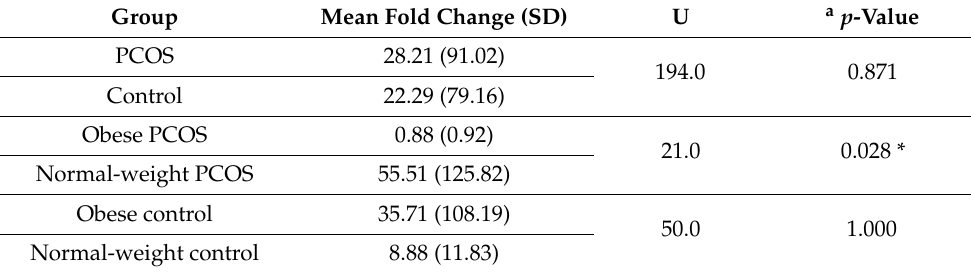
Table 4. Comparison of Hb-EGF expression level between study